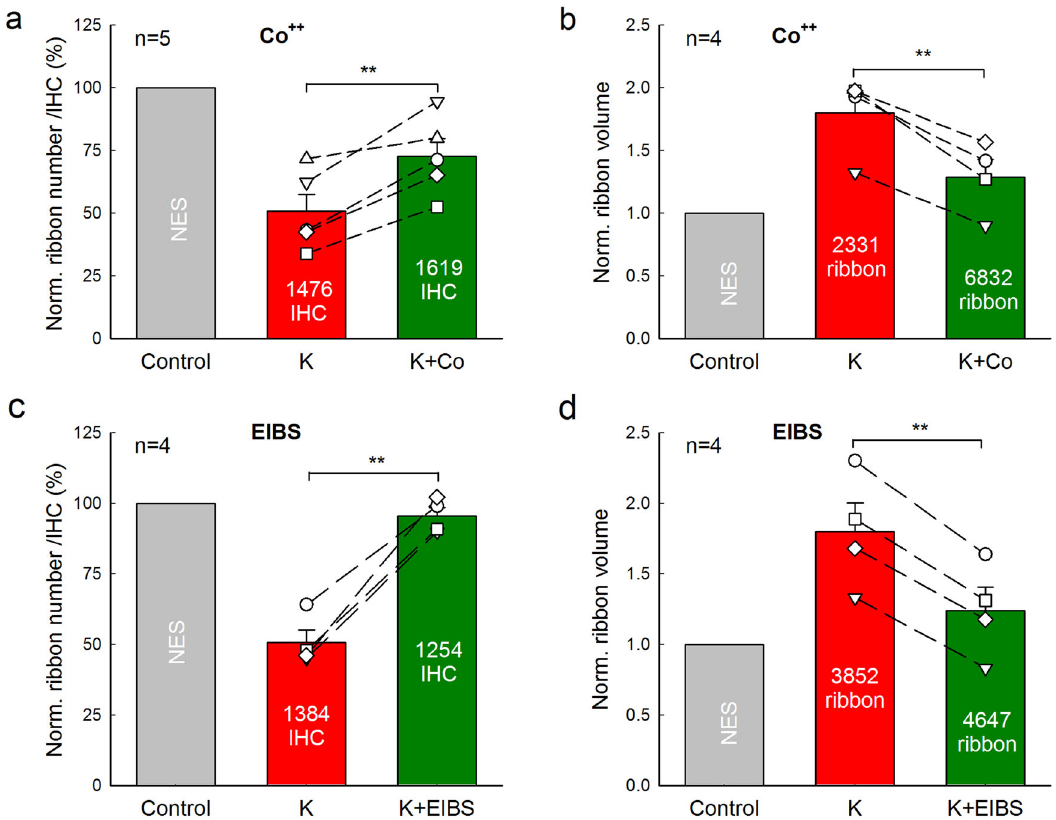
Fig. 4 Attenuation of IHC ribbon degeneration and swelling by Ca ++ channel blocker. a , b Attenuation of the Ca ++ channel blocker Co ++ on ribbon degeneration and swelling induced by high-K + challenge. Two cochleas of the same mouse were incubated separately in the 50 mM K + extracellular solution with 2 mM Co ++ (K + + Co ++ group) and 50 mM K + extracellular solution (high-K + group). Ribbon numbers and volumes pooled from all cochlear turns in both groups were separately averaged and normalized to that in the NES group in Fig. 1. Dashed lines connected two same symbols represent data collected from two cochleas of the same mouse. N is the animal number. Number in each bar represents accounted IHC or ribbon numbers. Co ++ signi fi cantly attenuates both ribbon degeneration and swelling induced by high-K + . c , d Attenuation of high-K + induced ribbon degeneration and swelling by extracellular ionic blocking solution (EIBS), which contains 20 mM TEA, 20 mM Cs + , and 2 mM Co ++ and can block both Ca ++ and K + channels extensively in the hair cells. One cochlea in a mouse was incubated in the high-K + (50 mM) extracellular solution (high-K + group) and another cochlea was incubated in the 50 mM K + with EIBS (K + + EIBS group) for 2 h. Ribbon numbers and volumes in both the high-K + group and the K + + EIBS group were separately normalized to those in the NES control group in Fig. 1. ** P < 0.01, paired t -test,